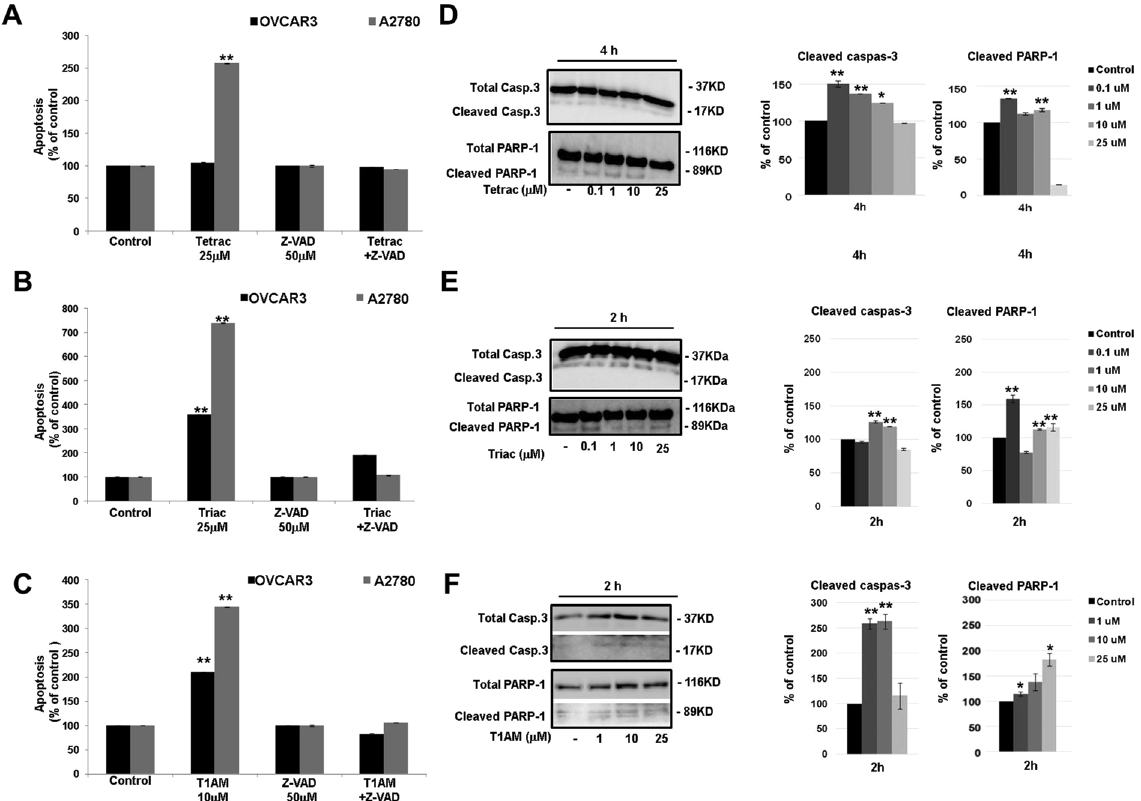
Figure 5. Caspase-dependent apoptosis by tetrac, triac and T1AM. Cells were treated with 25 μ M ( A ) tetrac ( B ) triac ( C ) 10 μ M T1AM, for 96 hours ± Z-VAD-FMK (50 μ M) and analyzed by annexin-V/PI. Experiments were repeated twice in triplicates. Cells were treated with 0.1, 1, 10 or 25 μ M ( D ) tetrac ( E ) triac or ( F ) T1AM, for 2 or 4 hours and caspase-3 and PARP-1 cleavage were analyzed by Western blots. Representative blot (cropped) is presented. Experiments were repeated twice. Significance from vehicle control (KOH) is indicated by * p < 0.05, ** p <